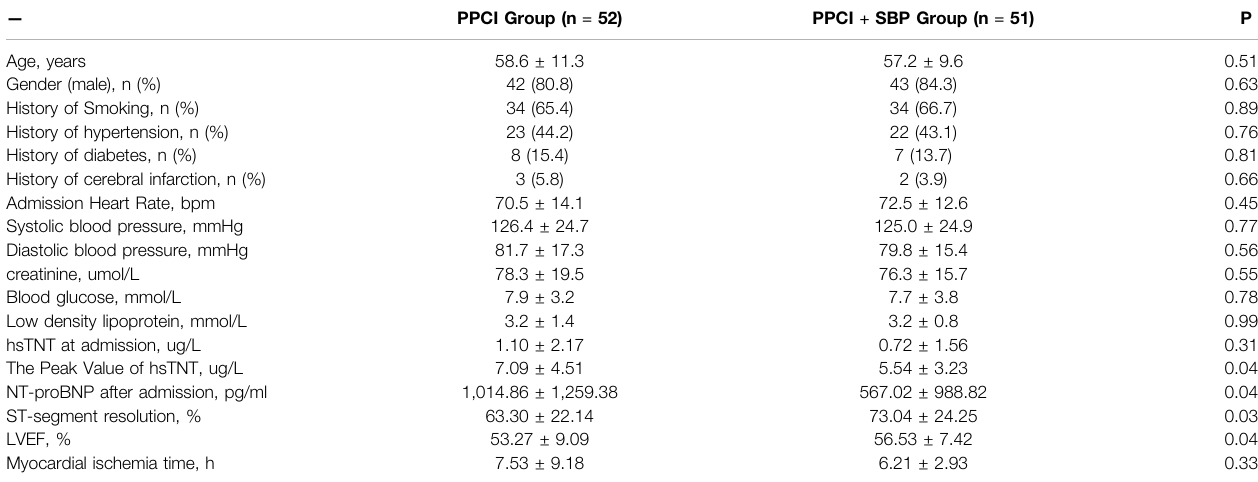
TABLE 1 | Comparison of clinical characteristics between PPCI + SBP and PPCI groups. — PPCI Group (n =